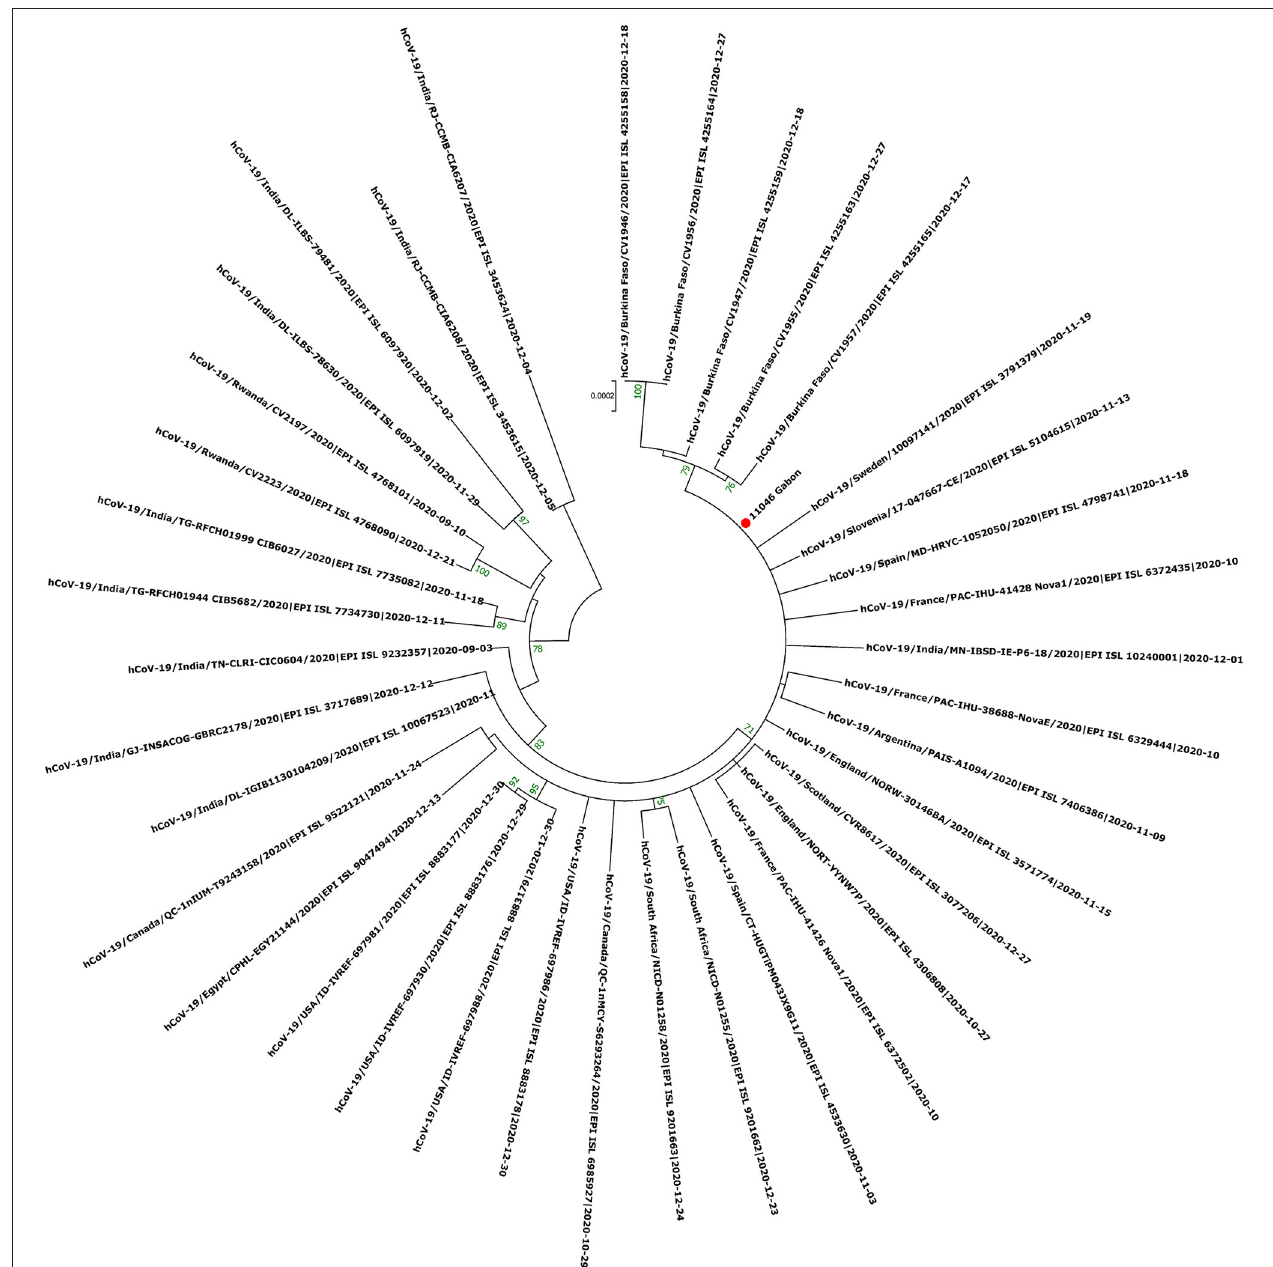
FIGURE 7 | Molecular Phylogenetic analysis by Maximum Likelihood method using one sequence from VOC Delta circulating during the first inter-wave in Gabon and 37 SARS-CoV-2 sequences available in GISAID. The evolutionary history was inferred by using the Maximum Likelihood method based on the Jukes-Cantor model. The tree with the highest log likelihood ( − 41765.89) is shown. Initial tree(s) for the heuristic search were obtained automatically by applying Neighbor-Join and BioNJ algorithms to a matrix of pairwise distances estimated using the Maximum Composite Likelihood (MCL) approach, and then selecting the topology with superior log likelihood value. The tree is drawn to scale, with branch lengths measured in the number of substitutions per site. The analysis involved 38 nucleotide sequences. All positions with < 80% site coverage were eliminated. That is, fewer than 20% alignment gaps, missing data, and ambiguous bases were allowed at any position. There were a total of 27791 positions in the final dataset. Evolutionary analyses were conducted in MEGA7. The red circle correspond to the genome identified in this study. Senegal SN (EPI_ISL_1910388, EPI_ISL_2620887) and also Benin NMIMR (EPI_ISL_7140058, EPI_ISL_7140061), the two other sequences from another Gabonese study in the third cluster was composed of sequences from Marseille region of Lambaréné (EPI_ISL_2156809, EPI_ISL_2424159) (EPI_ISL_5636399 and EPI_ISL_5636402 belonging to the ( Figure 8 ). The second cluster was made of sequences from Alpha VOC). Finally, one sequence (ID4746) formed a